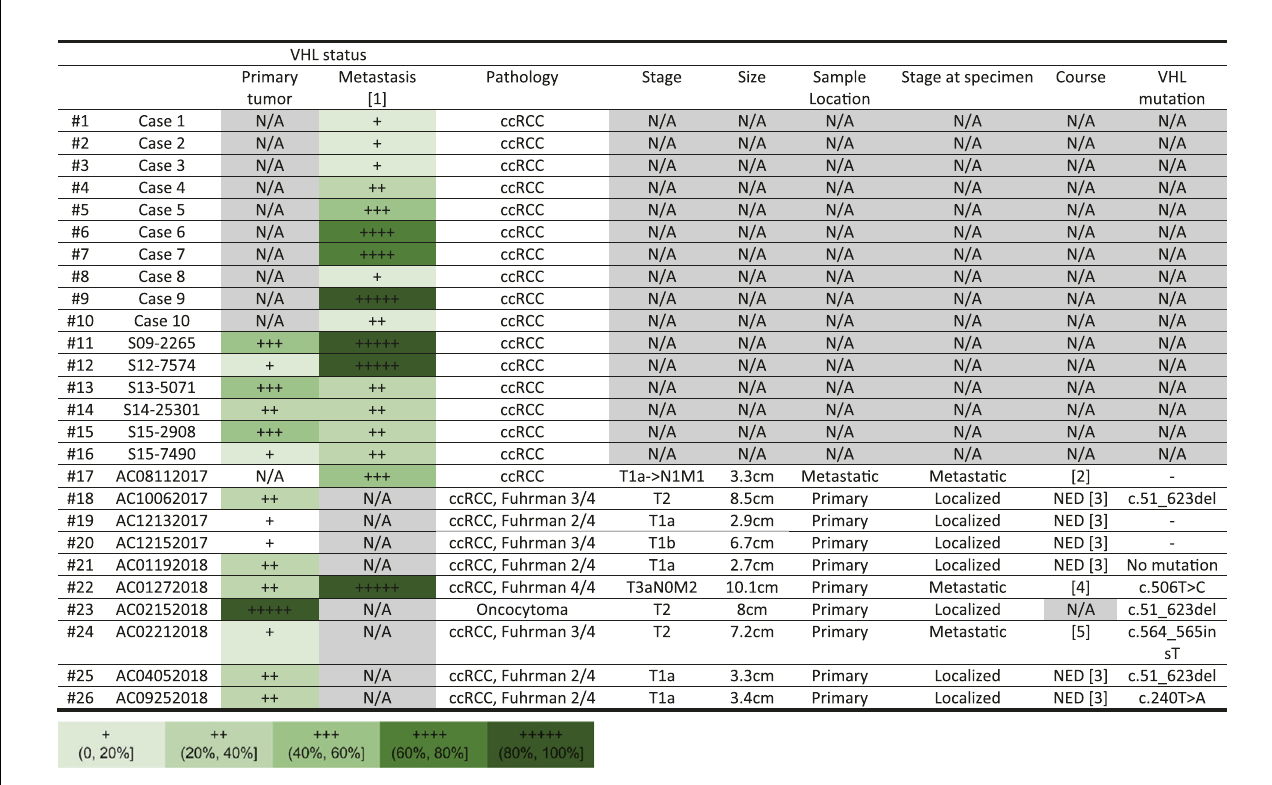
Table 1. VHL status summary of human ccRCC